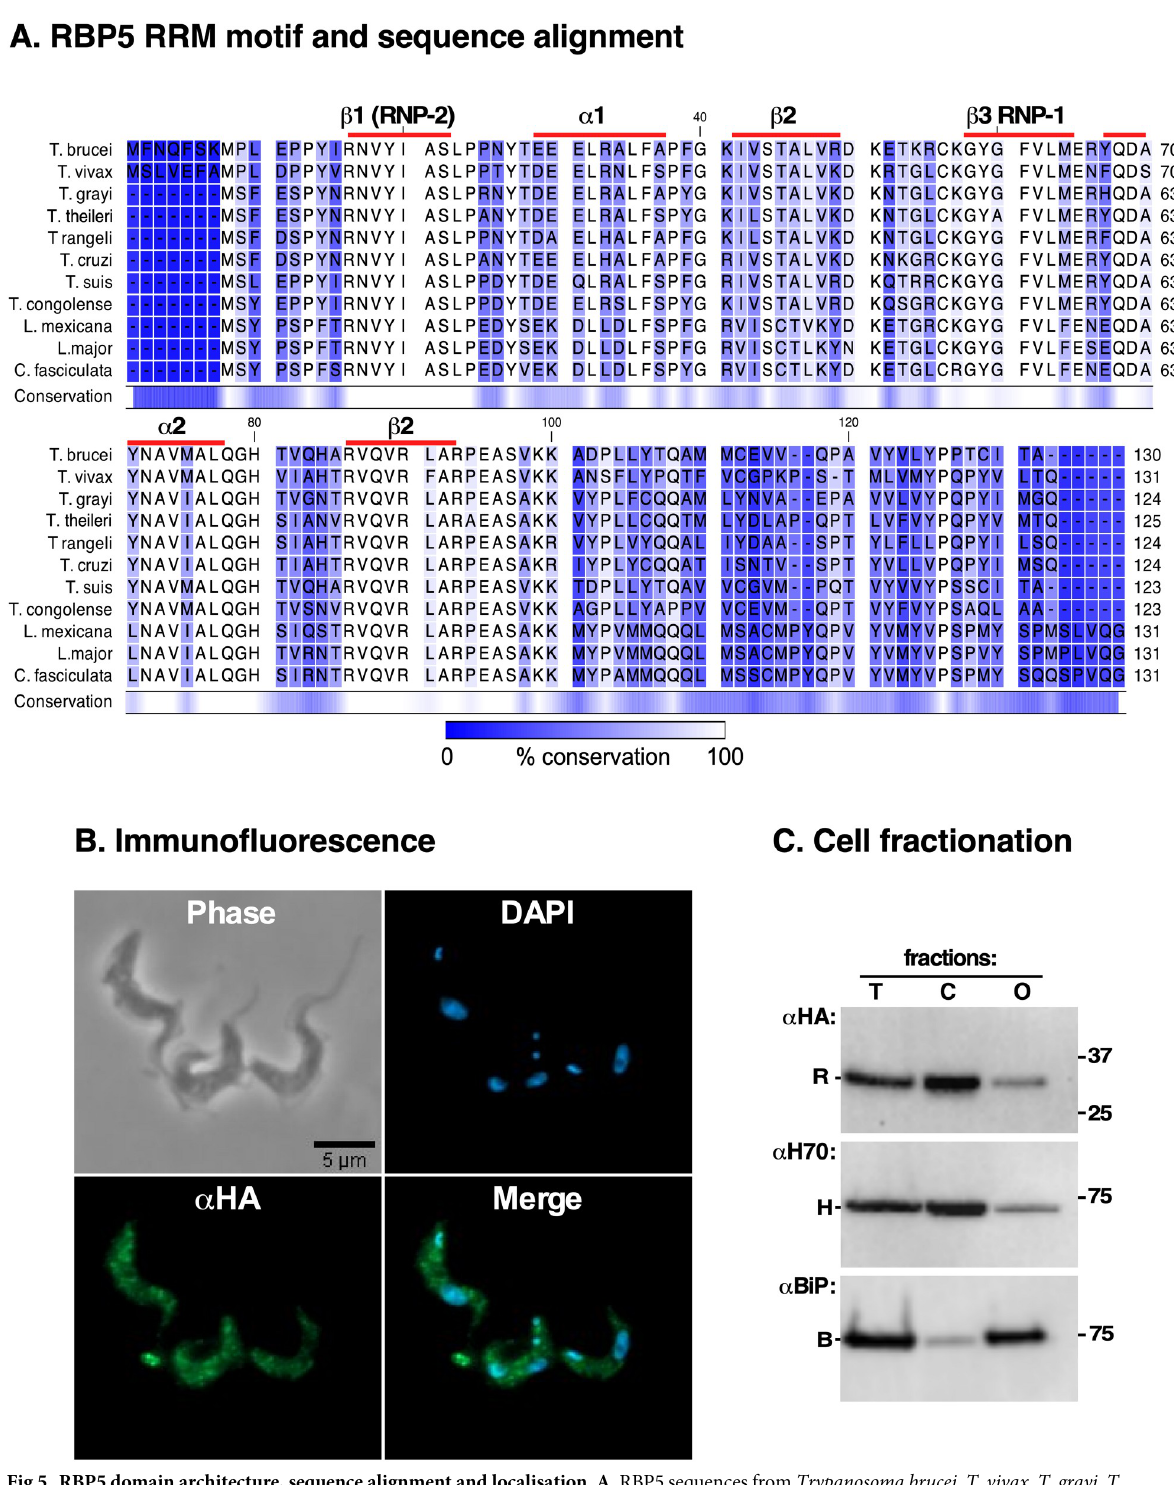
Fig 5. RBP5 domain architecture, sequence alignment and localisation. A . RBP5 sequences from Trypanosoma brucei , T . vivax , T . grayi , T . rangeli , T . congolense , T . theileri , T . cruzi , T . suis , Leishmania major , L . mexicana , and Crithidia fasciculata were aligned using CLC Genomics Workbench (Qiagen). The blue shading highlights percent conservation according to the bar below. Secondary structure elements depicting its single RNA Recognition Motif (RRM) are highlighted by red lines above respective amino acid residues as predicted by PFAM; (e-value 1.6e-18). B . Immunofluorescence staining of HA::RBP5 epitope-tagged cells visualized with α HA (green; RBP5) and DAPI (blue; nucleus and kinetoplast DNA).